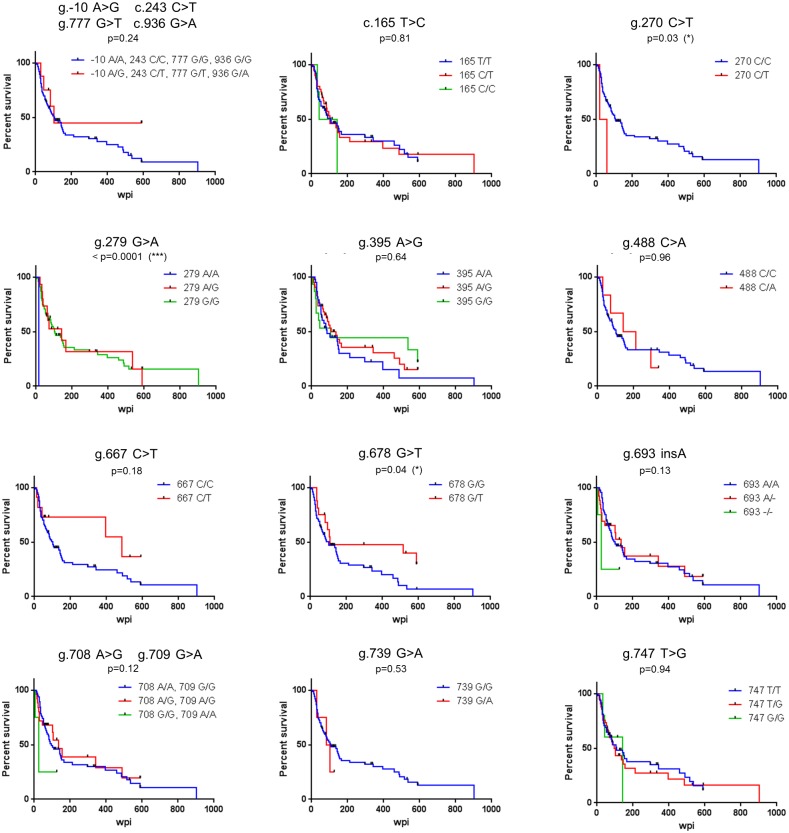
IFITM3 alleles and disease progression in SIV-infected rhesus macaques.For each polymorphism, the AIDS free survival (percent survival) is shown in Kaplan-Meier plots. Censored animals are shown as black ticks. The polymorphisms are indicated above each diagram along with the p-values obtained by the log-rank test. AIDS free survival time is shown as weeks post infection (wpi). Statistical significant results are depicted as follows, *, p<0.05; **, p<0.01; ***, p<0.001.